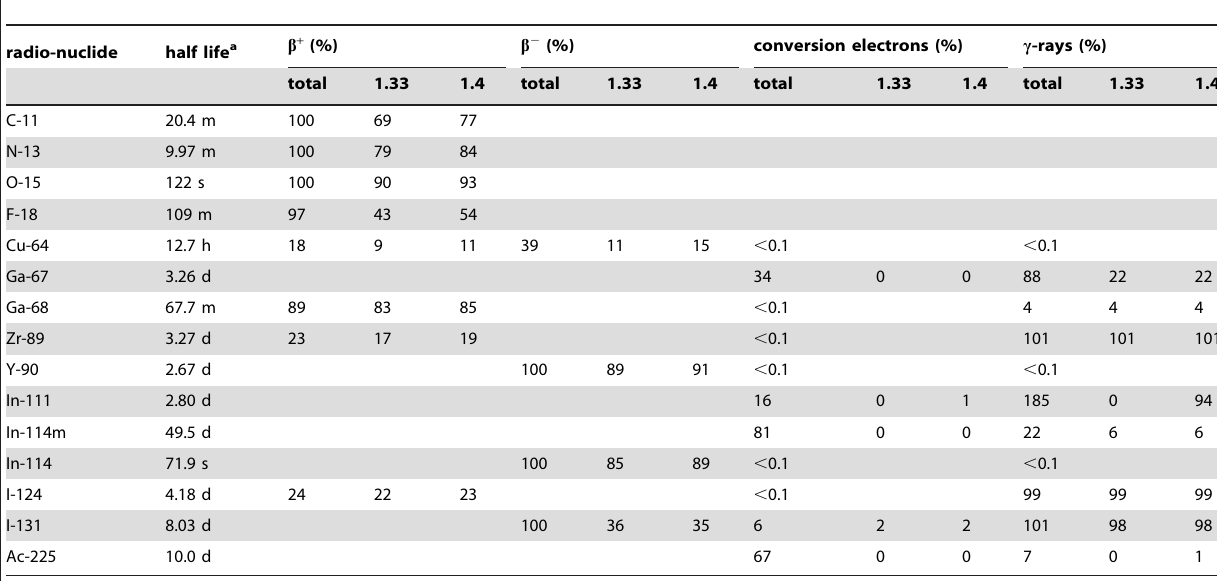
Table 1. Total abundance and abundance of emissions having energy greater than CR thresholds in water and in biological